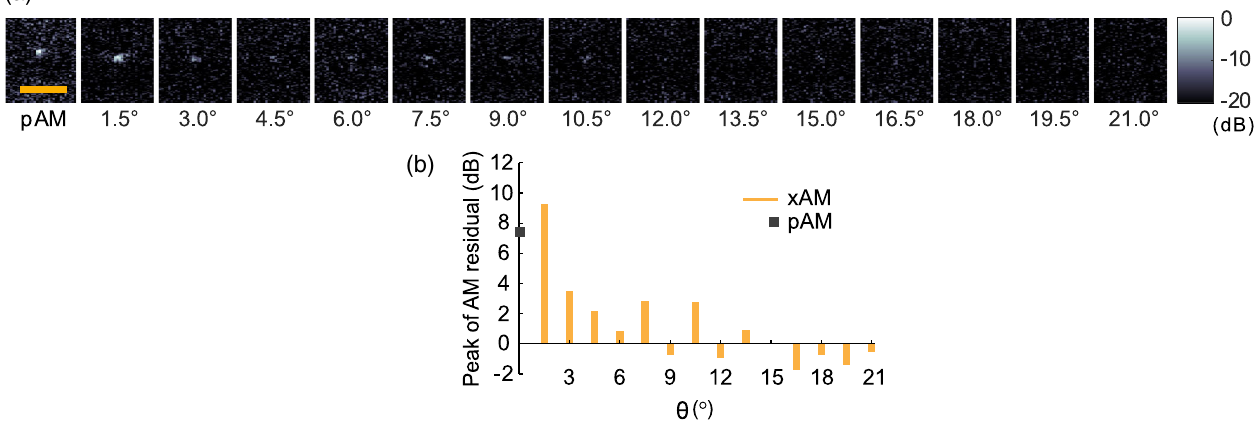
FIG. 4. xAM images of the cross section of a subwavelength nickel wire as a function of the cross-propagation angle θ . (a) Images reconstructed from the three component transmissions of the pAM code and xAM code at angles ranging from 1.5° to 21°. The wire is positioned at a depth of 4 mm. Each image depth ranges from 3.0 mm to 4.5 mm and each width from − 1 . 5 mm to 1.5 mm. Scale bar: 1 mm. (b) Peak AM residual signal as a function of the xAM sequence angle θ . The xAM signals are labeled in orange; the pAM signal is labeled with a gray square symbol. Values in dB represent the peak value of the residual signal relative to the peak value of the